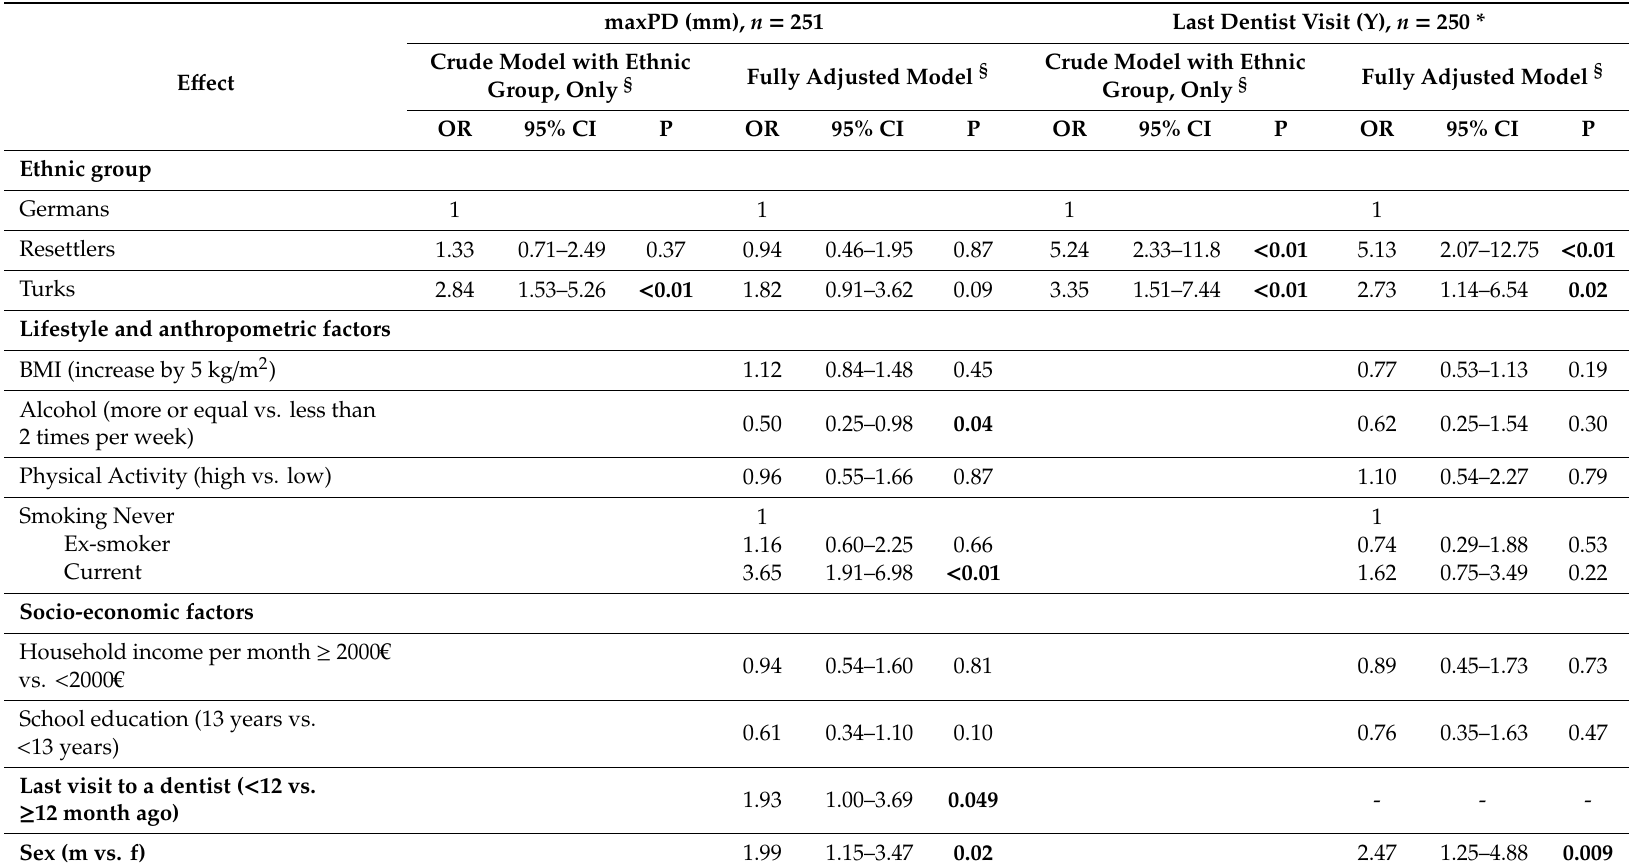
Table 3. Results of multivariable ordinal logistic regressions on maxPD and Last Dentist Visit by ethnic groups. maxPD (mm), n = E ff ect